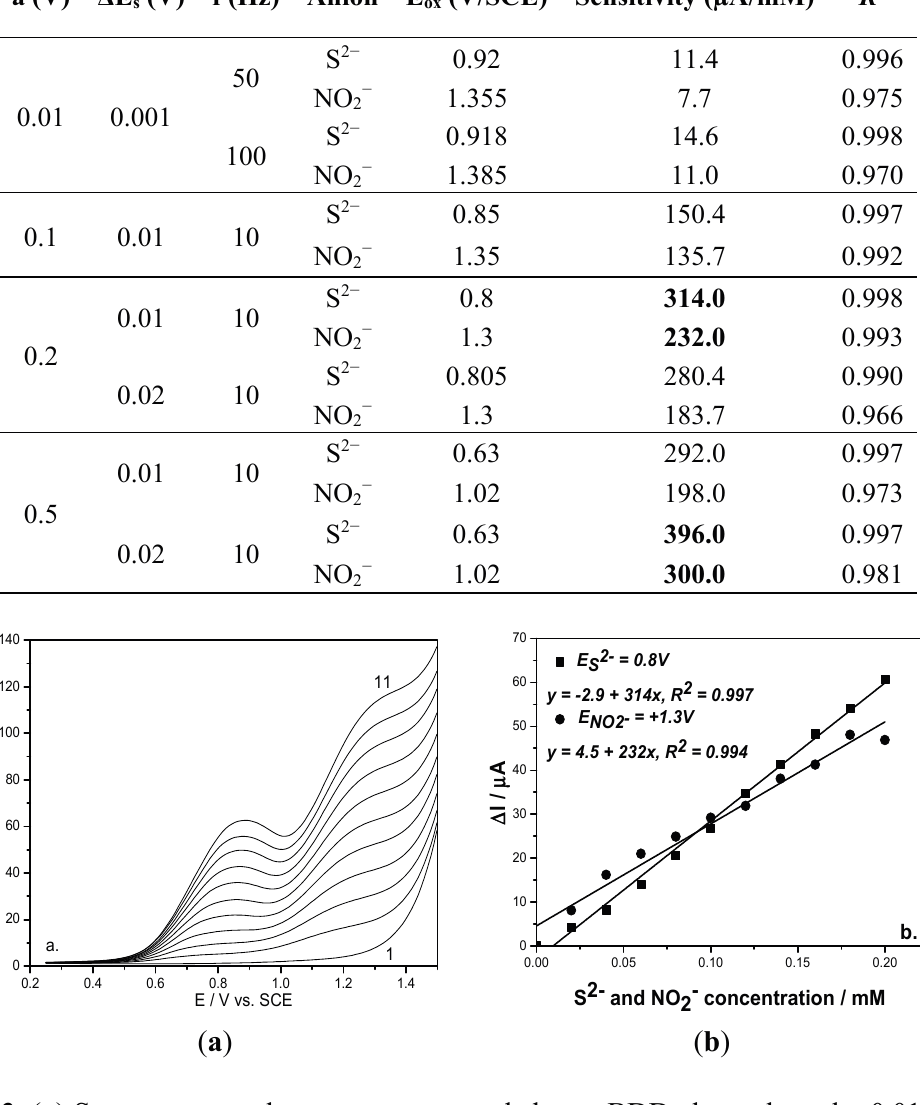
Figure 3. ( a ) Square-wave voltammograms recorded on a BDD electrode under 0.01 V step potential and 0.2 V modulation amplitude, 10 Hz frequency, 0.1 V·s − 1 scan rate, between − 0.25 and +1.5 V vs . SCE in 0.1 M Na 2 SO 4 supporting electrolyte (curve 1) and in the presence of mixtures of 0.02–0.2 mM sulfide and nitrite concentrations (curves 2–11); ( b ) Calibration plots of the current vs . anion concentrations recorded at: E = +0.8 V/SCE for sulfide concentration and E = +1.3 V/SCE for nitrite